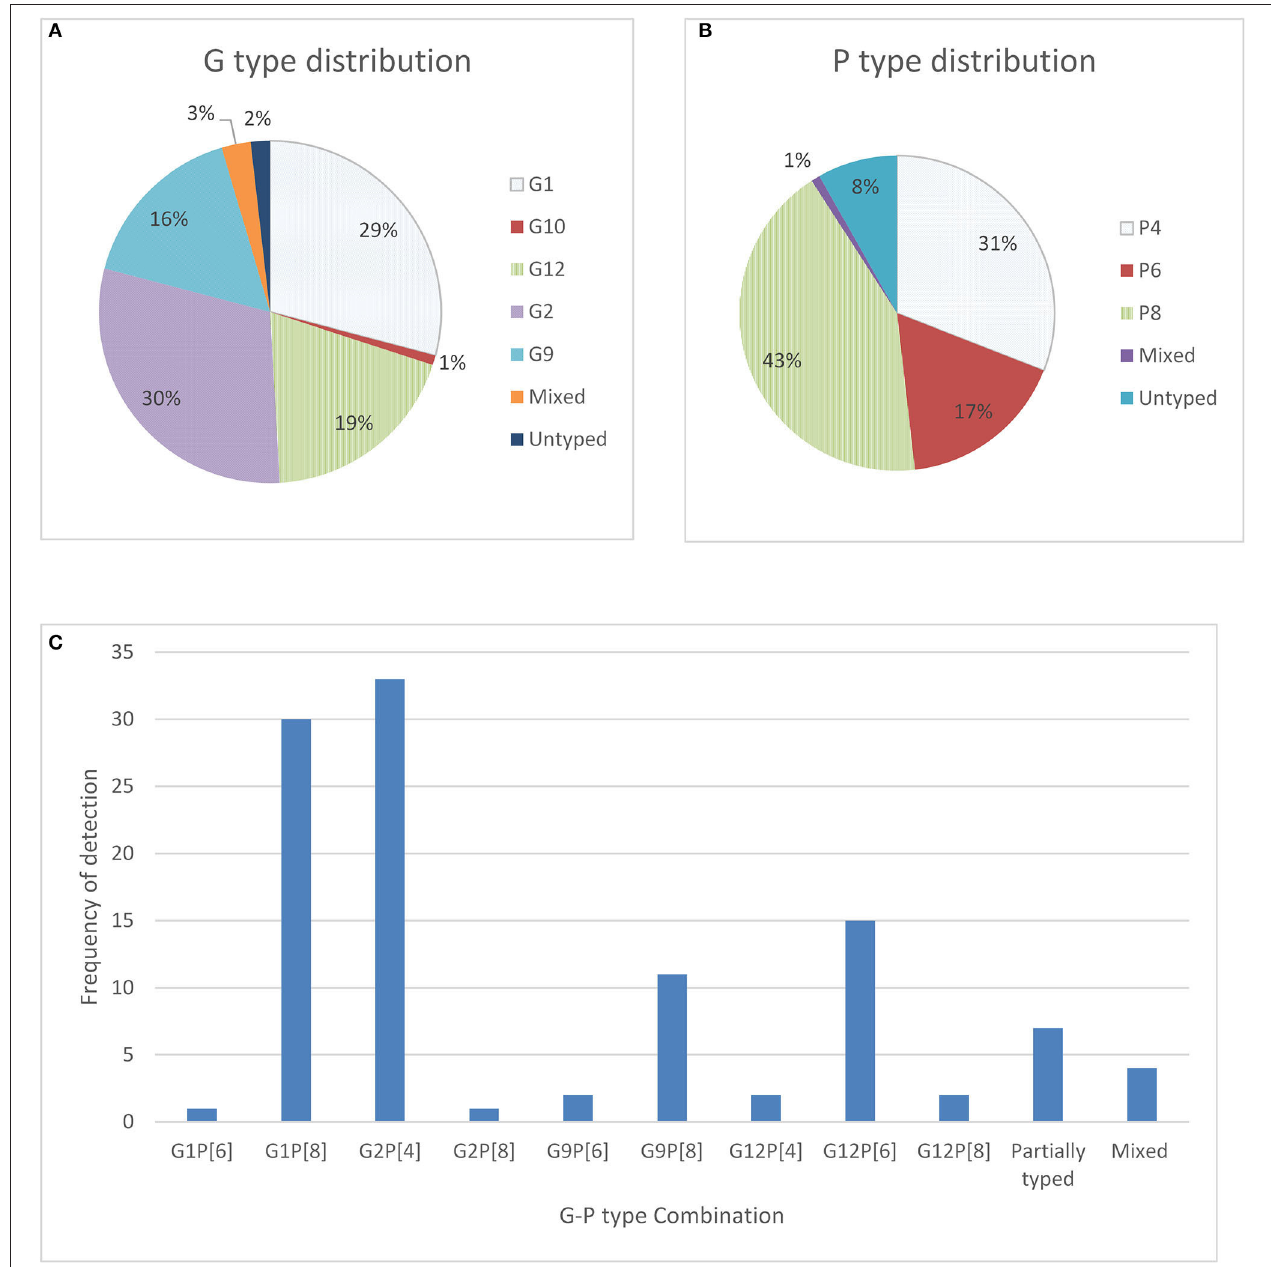
FIGURE 1 | Distribution of G types and P types; (A) total percentage of different G types detected in children with symptoms as well as without symptoms (B) total percentage of P types rotavirus strain detected among children with symptoms as well as without symptoms and (C) frequency and cumulative percentage of G and P genotypes of rotavirus stains detected among community